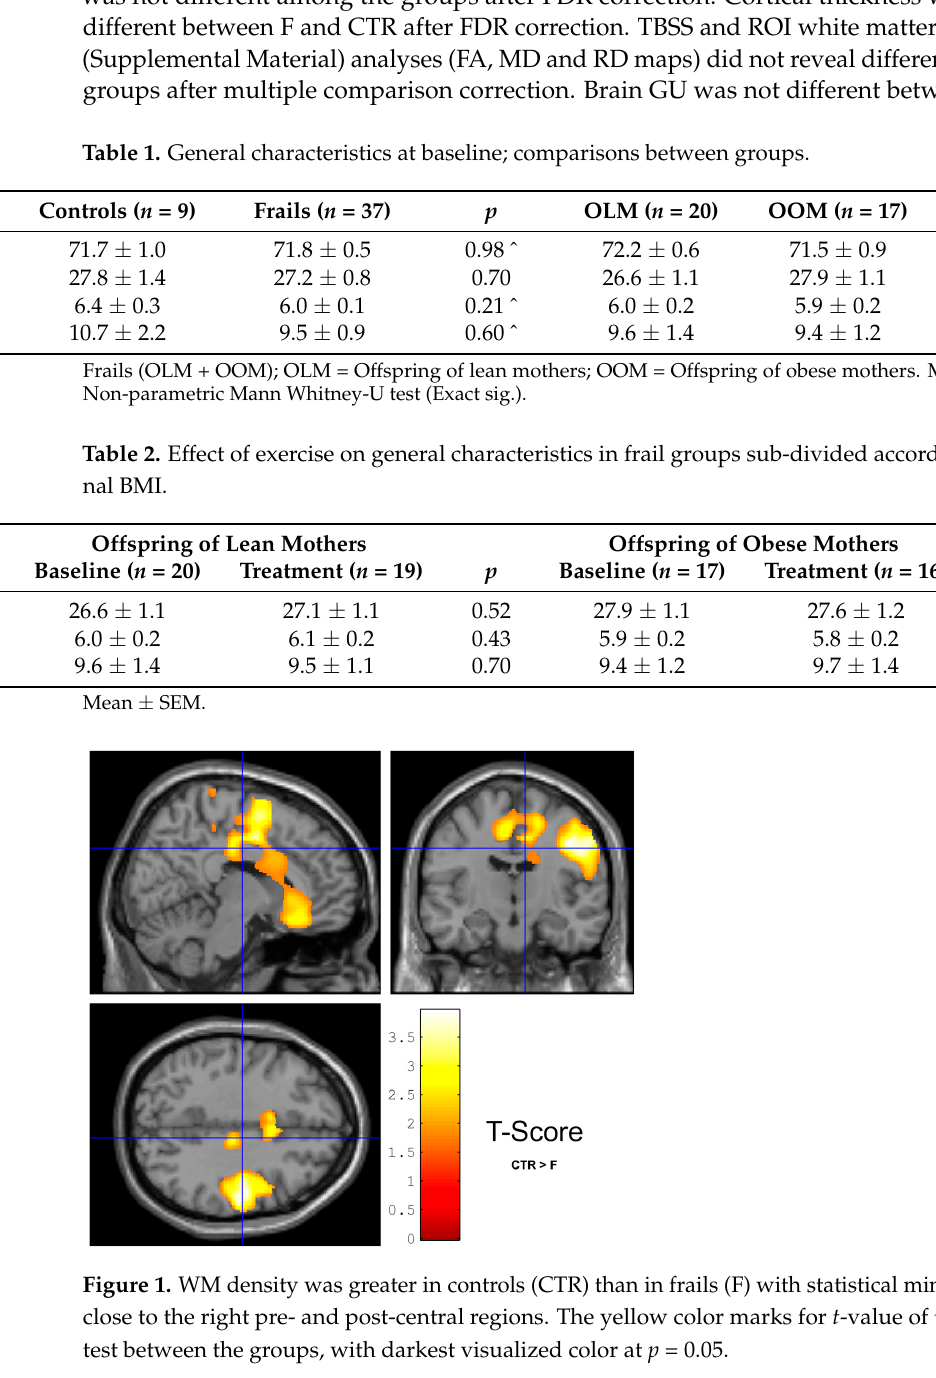
Figure 2. WM density was greater in OLM compared to OOM ( green ) and was greater in CTR than in OOM ( blue ). The two-color scales represent the t-values of the statistical test. The lowest visual- ized t -value in the color scales corresponds to p = 0.05. The red area shows the intersections be- tween the two statistical maps. VBM analysis of GM density did not result in signi fi cant di ff erences between the three groups (OLM, OOM, and CTR), after correcting for age. Freesurfer results con fi rmed VBM analysis when corrected for FDR, and no di ff er- ence remained signi fi cant. Cortical thickness statistical surface maps, LGI, TBSS, and ROI white ma tt er atlas-based (Supplemental Material) analyses (FA, MD and RD maps), did not show statistical di ff erences between OLM, OOM, and CTR after multiple comparison correction. Brain glucose uptake was not di ff erent between groups.